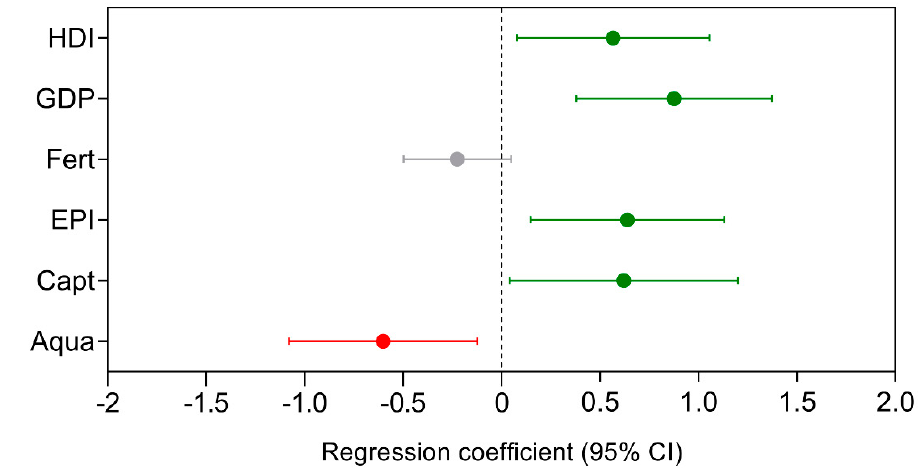
Figure 6. Coefficient estimates (± 95% confidence intervals) indicating the magnitude and direction of economic, environmental and social variables tested for a model of scientific production of dinoflagellates. Gray markers represent predictors without significant influence, red and green represent negative and positive effects, respectively.